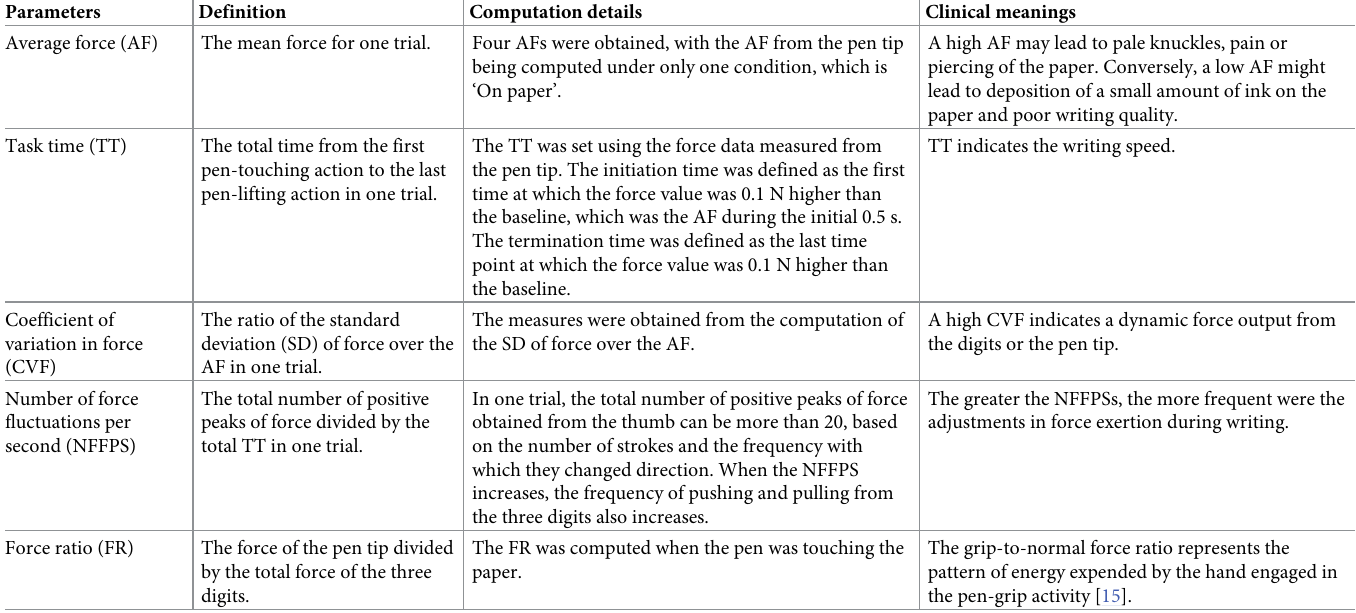
Table 1. Definition, computation and clinical meanings of the five kinetic